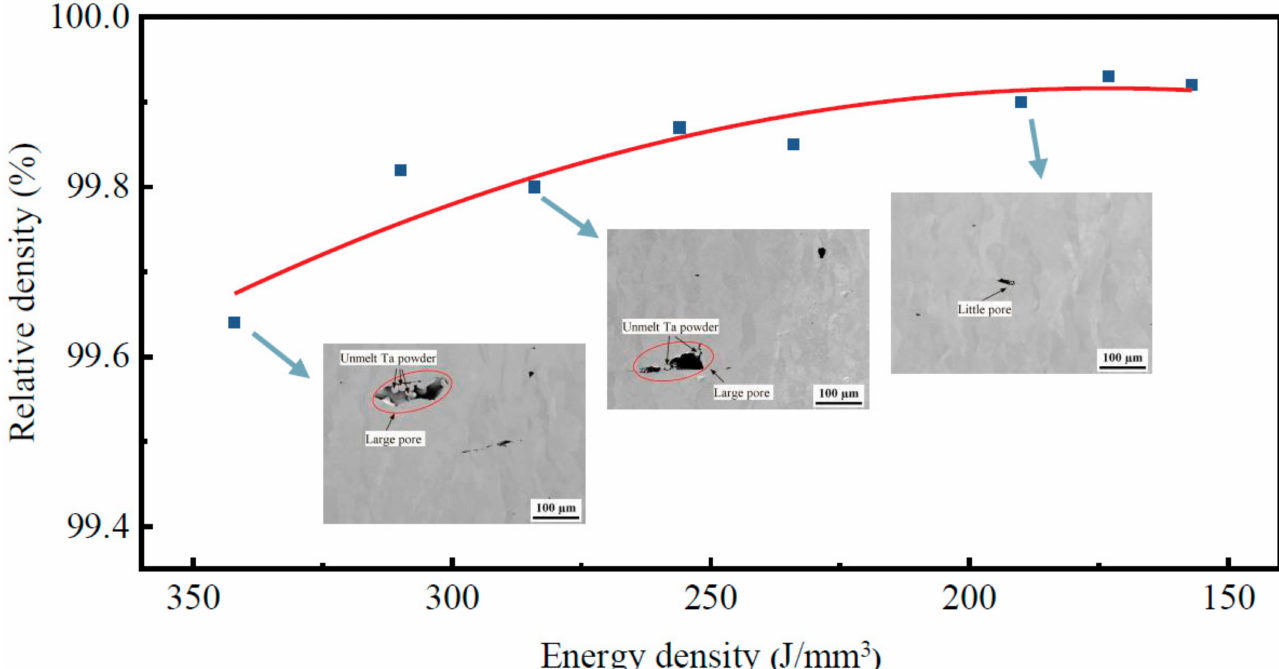
Figure 4. The relative density results of SLMed Ta made with different energy densities and corre- sponding SEM images along the building